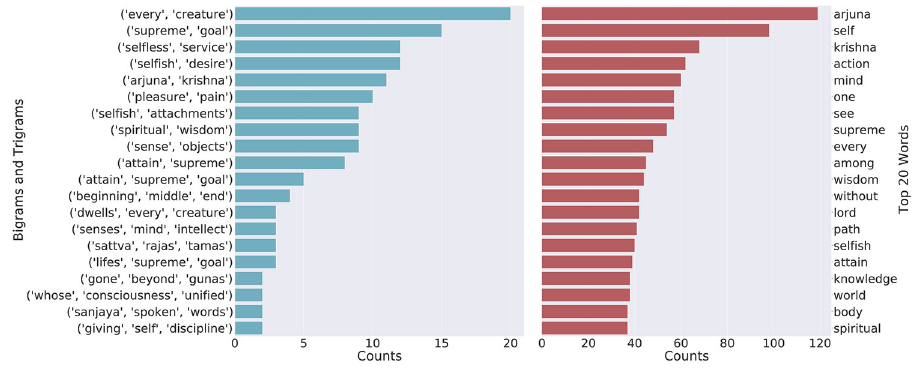
Fig 6. Visualisation of top 20 words, and top 10 bigrams and trigrams for the Bhagavad Gita.